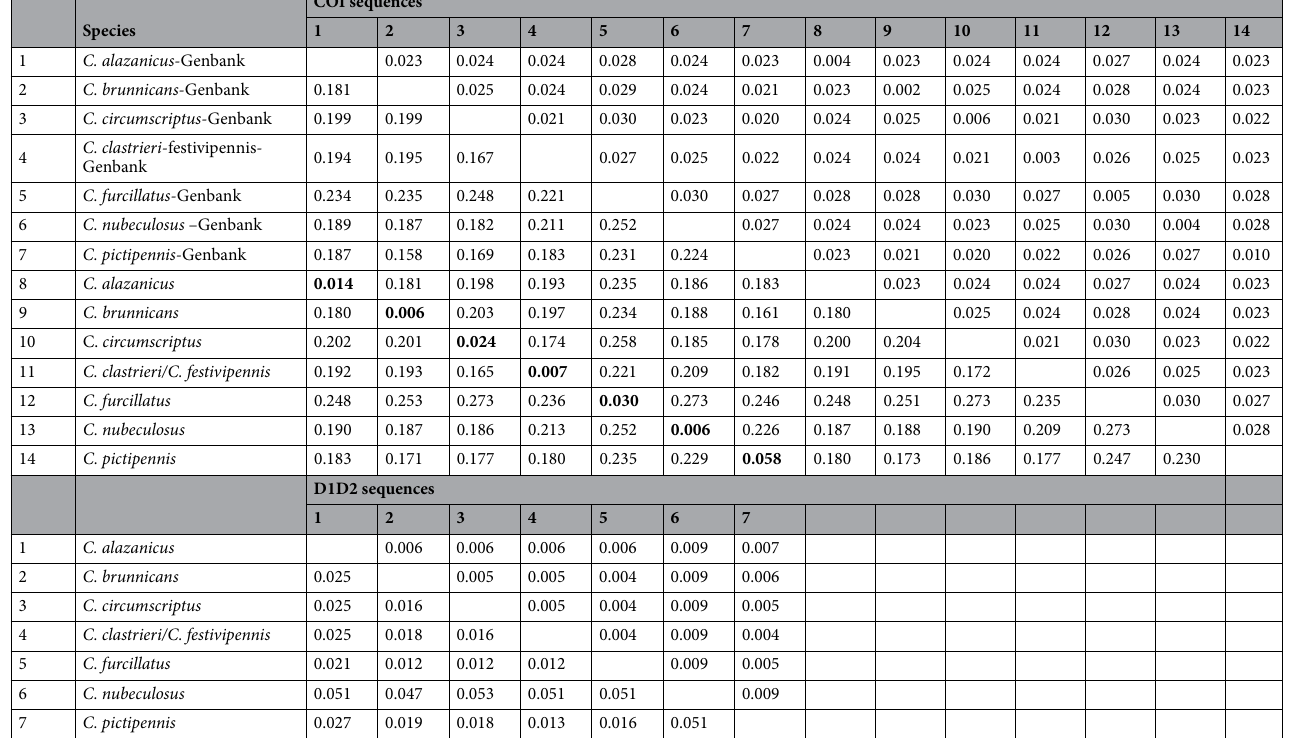
Table 1. Estimation of pairwise distance (± SD) of the Culicoides species for the COI domain of the mtDNA and D1D2 region of the